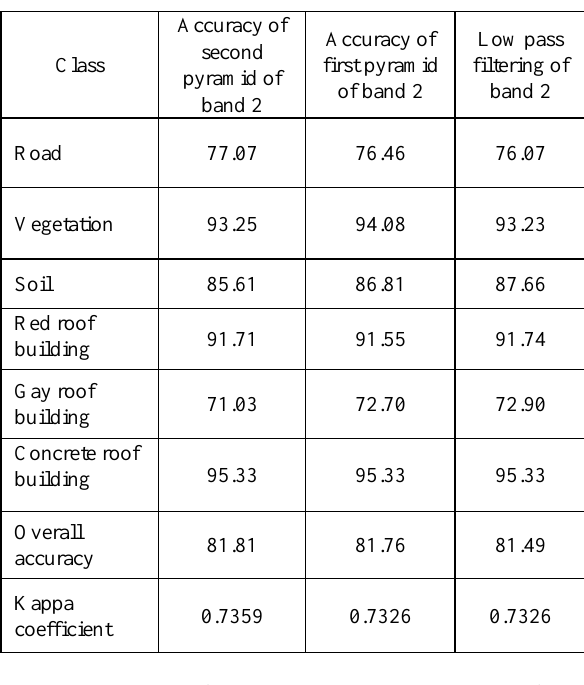
Table 2. accuracies of the applied pyramids and low-pass filter on the second selected band of the data set